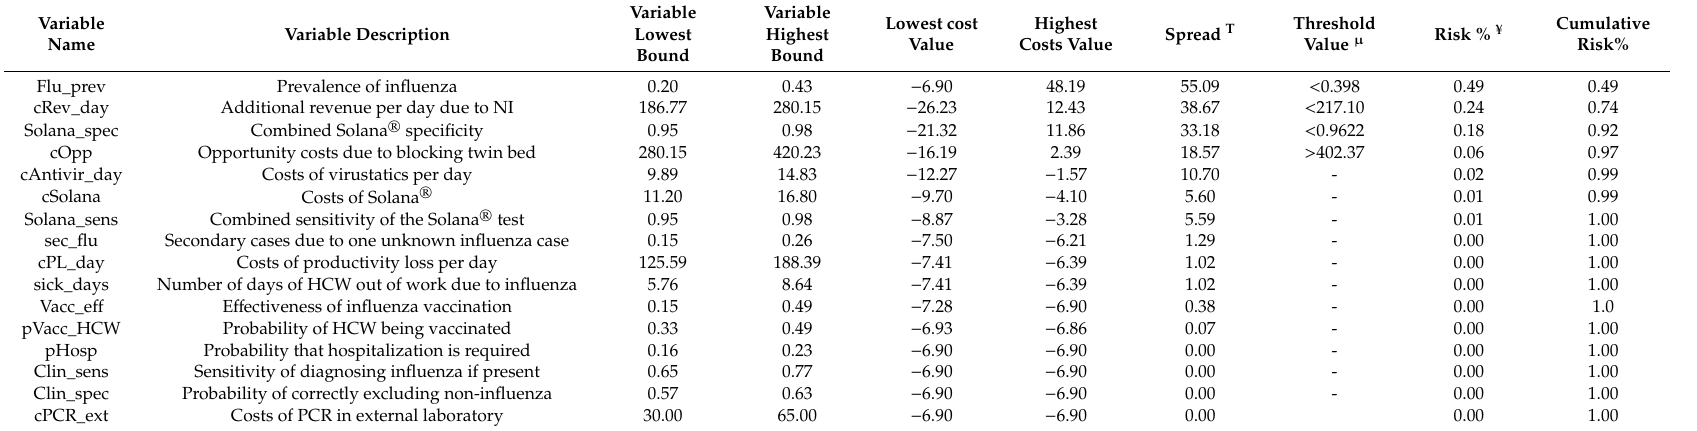
Table 3. Tornado diagram * (real-time influenza testing versus the conventional clinical